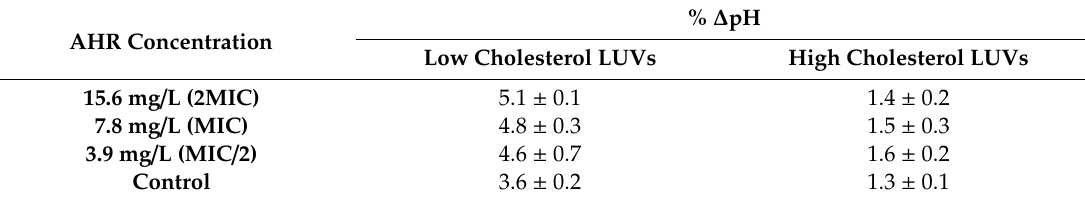
Table 3. E ff ect of di ff erent concentrations of AHR on lipid bilayer passive permeability to protons monitored through HPTS ratiometric fluorimetry, at 25 ◦ C. The experiments were conducted in lipid mixtures containing low and high concentrations of cholesterol. The percentage of pH-gradient dissipation (% ∆ pH) presented is related to the outward movement of protons trough the lipid bilayer before the total dissipation of pH gradient. The values are the mean ± S.D. of three independent